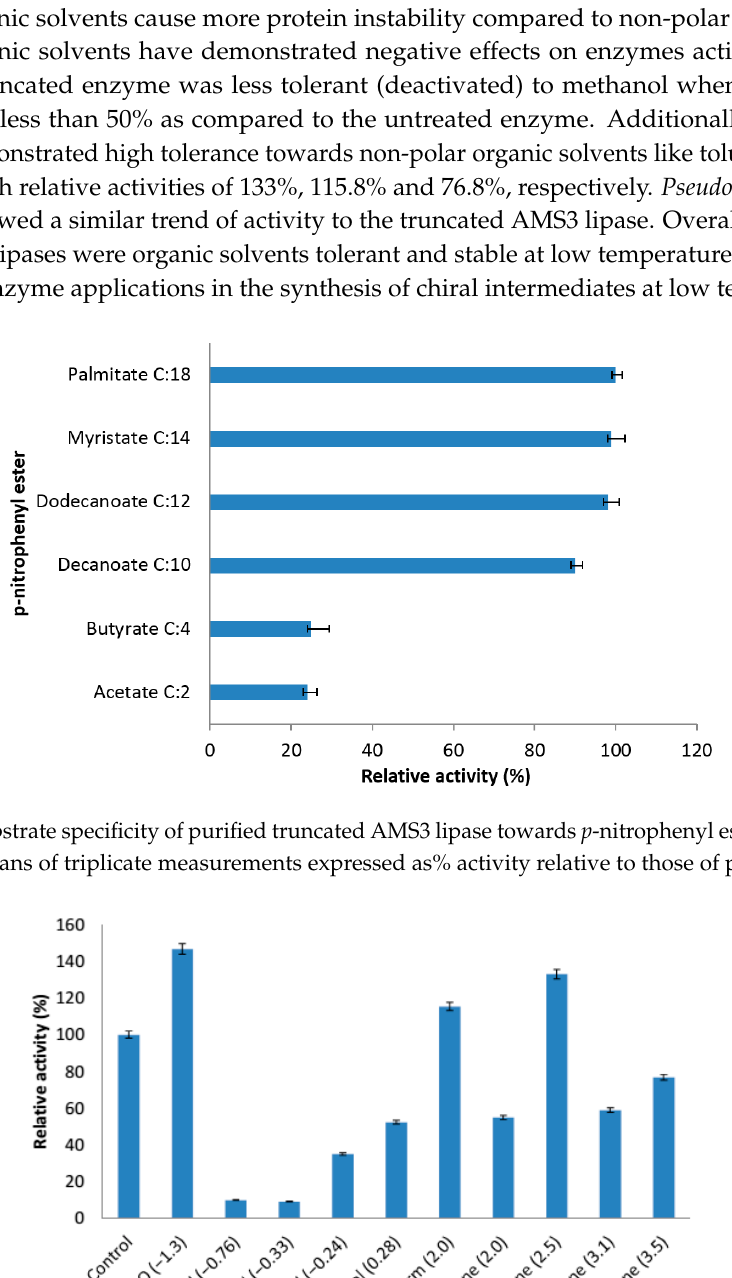
Figure 9. Effects of metal ions on truncated AMS3 lipase stability. Truncated AMS3 lipase activity was enhanced in the presence of a few metal ions. The enzyme was pre-incubated at 60 °C with various metal ions at concentrations of 1 and 5 mM.